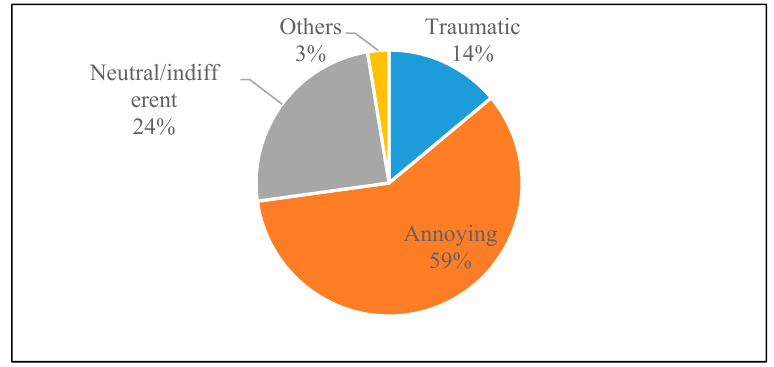
Figure 4. Resident’s perceptions of floods.